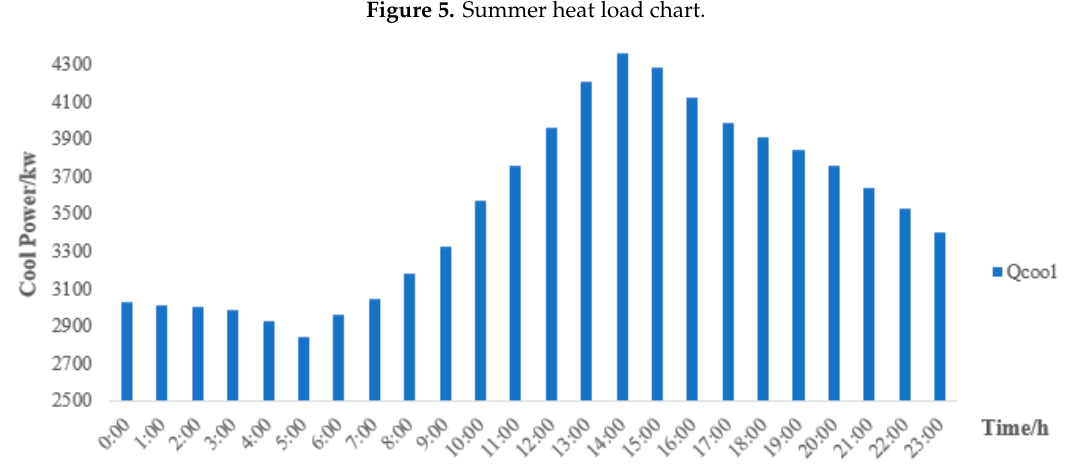
Figure 6. Summer cooling load chart.